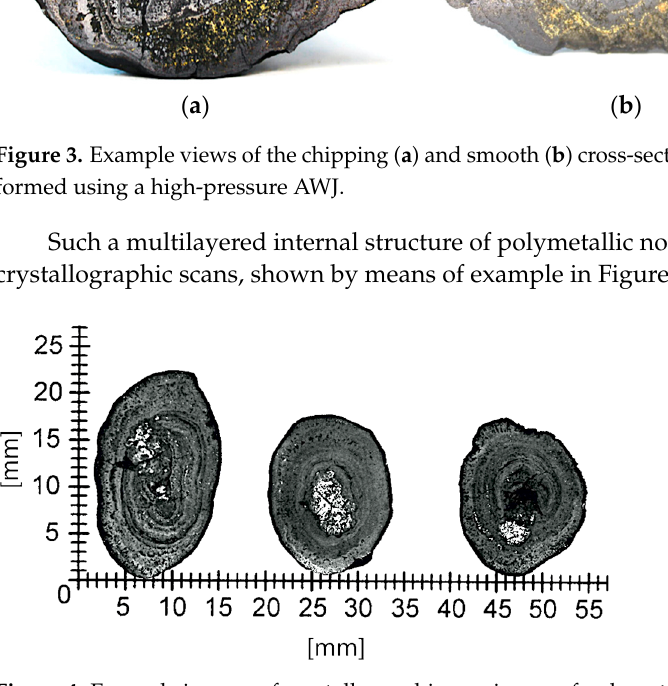
Figure 4. Example images of crystallographic specimens of polymetallic nodules.